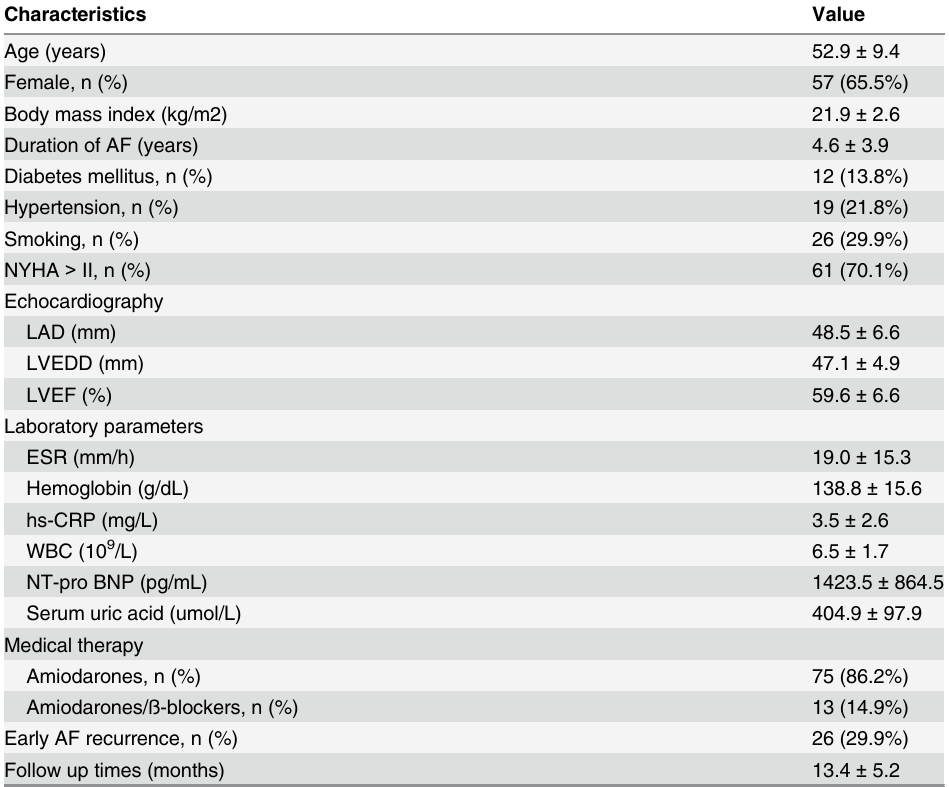
Table 1. Clinical characteristics of